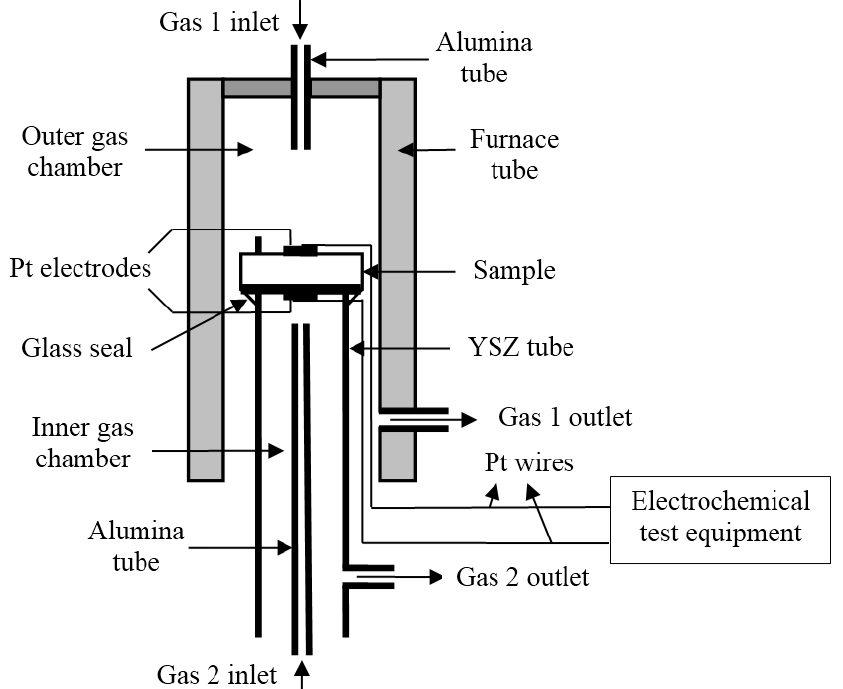
Figure 1. A schematic representation of the apparatus for electrochemical testing of concentration cells.